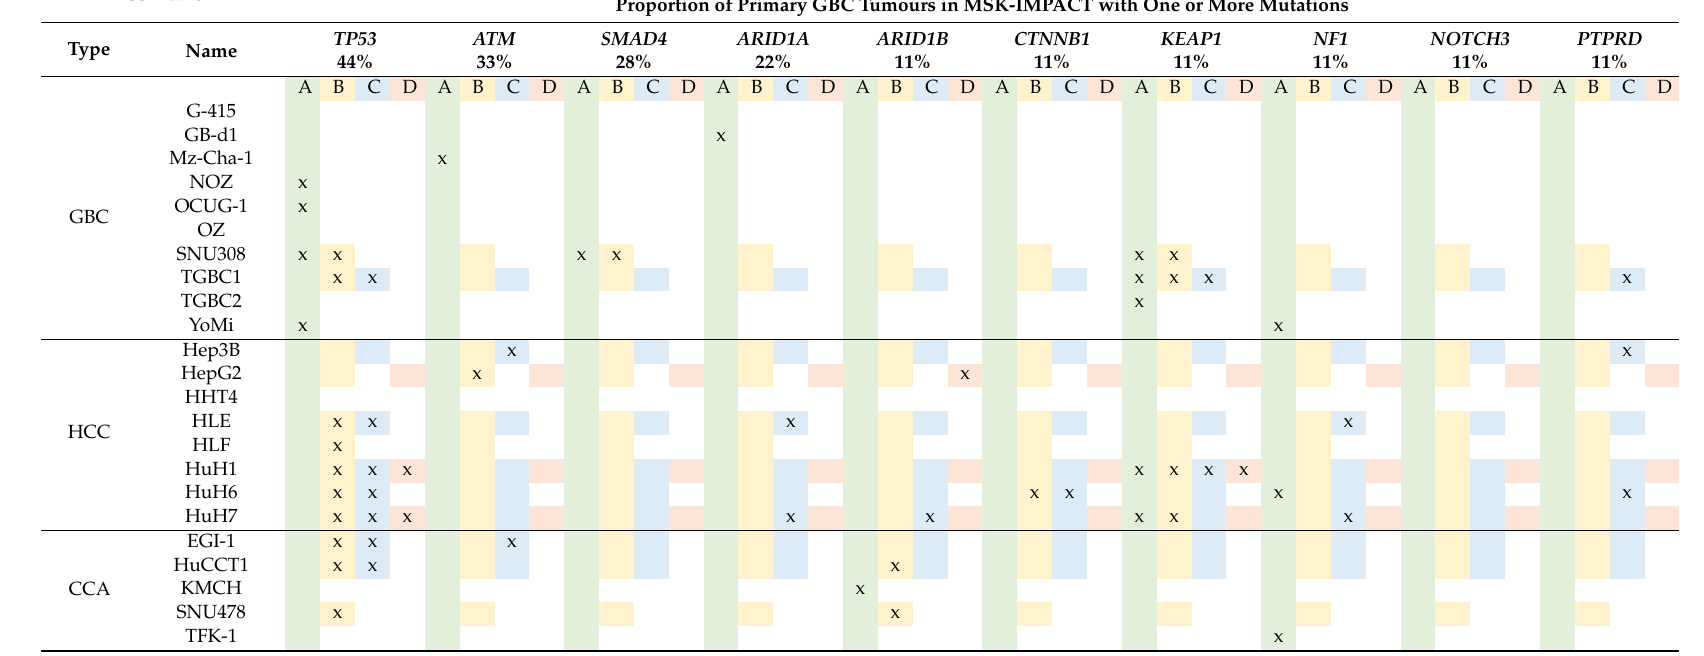
structure (exons for all potential isoforms from Ensembl are included), (3) the detected exonic mutations with at least 20 × coverage, with GBC, HCC, and CCA cell lines depicted in blue (mutations = triangles), red (mutations = circles), and green (mutations = squares), respectively, and (4) sequencing coverage, where darker colors indicate increasing sequencing depth, with GBC in blue, HCC in red, and CCA in green. ( b ) Identified mutations in genes with a mutation frequency of at least 10% in primary GBC tumors according to MSK-IMPACT are depicted using MutationMapper (green: missense mutations, black: truncating mutations, red: in-frame mutations, violet: fusion mutations, pink: any other mutation type). Table 1. Mutations in hepatobiliary cancer cell lines detected by RNA sequencing. GBC—gallbladder cancer; HCC—hepatocellular carcinoma; CCA—cholangiocarcinoma. Gene Cell Line Proportion of Primary GBC Tumours in MSK-IMPACT with One or More Mutations Type